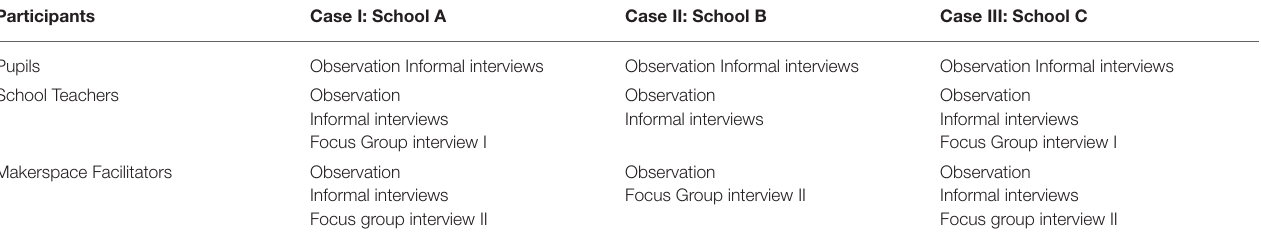
TABLE 3 | Data Collection Methods of the three